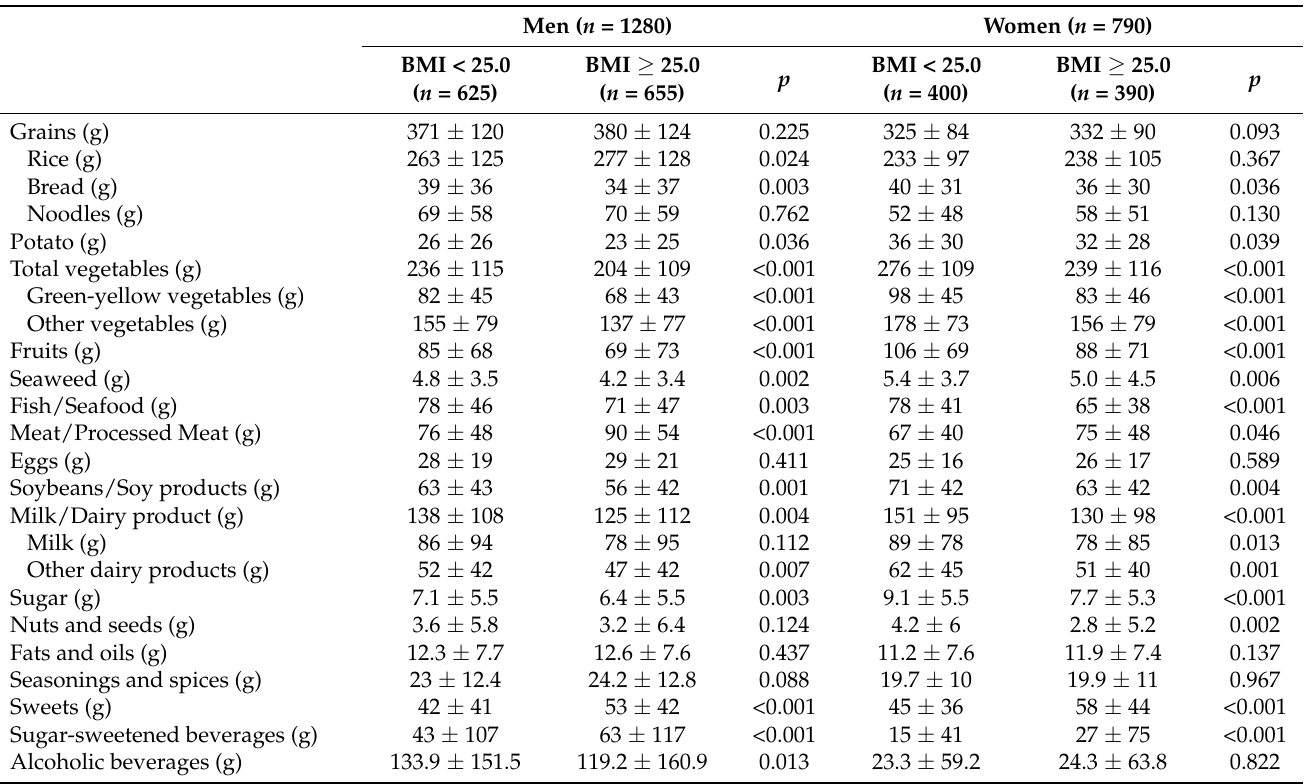
Table 2. Food groups stratified by sex and obesity